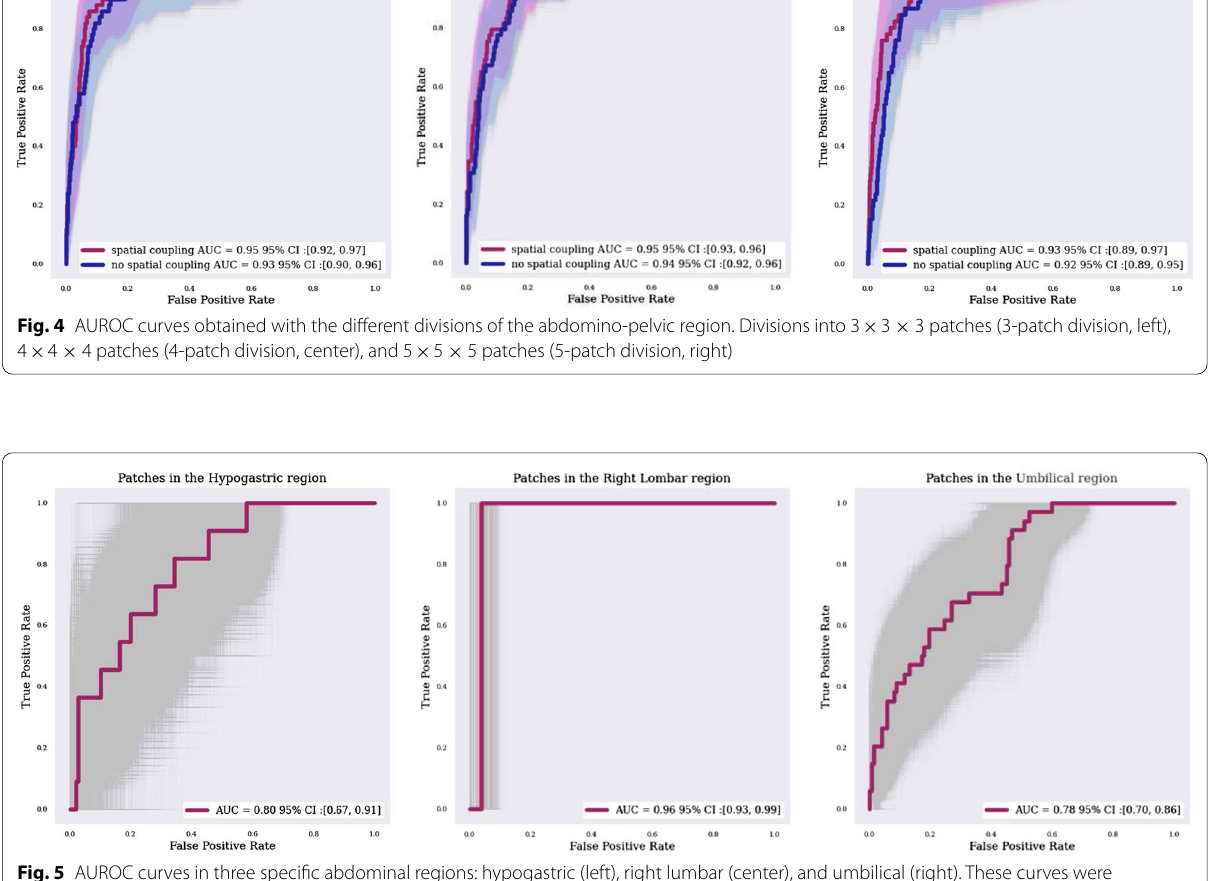
Fig. 5 AUROC curves in three specific abdominal regions: hypogastric (left), right lumbar (center), and umbilical (right). These curves were computed by summed the patch classification scores in hypogastric, lumbar and umbilical regions